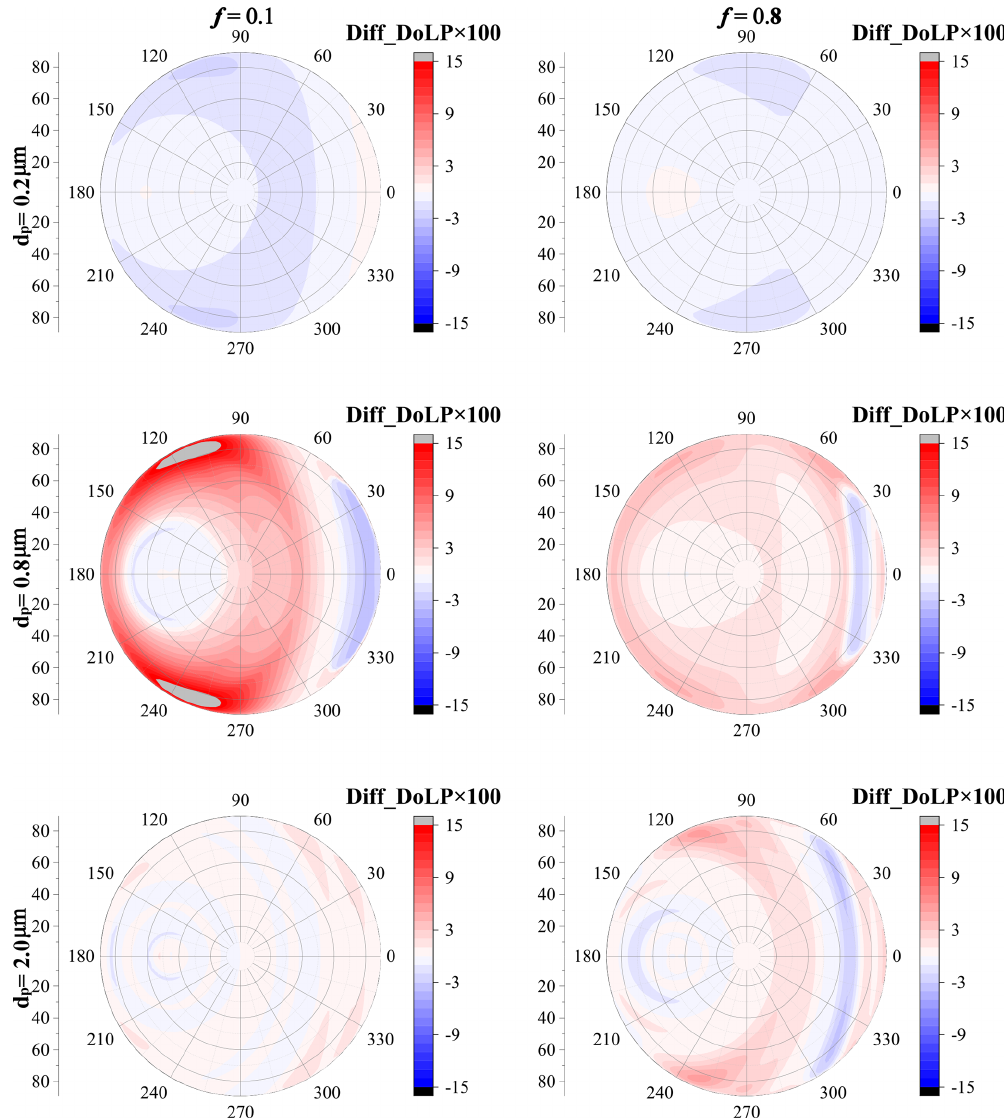
Figure 15. Similar to Fig. 14 but for